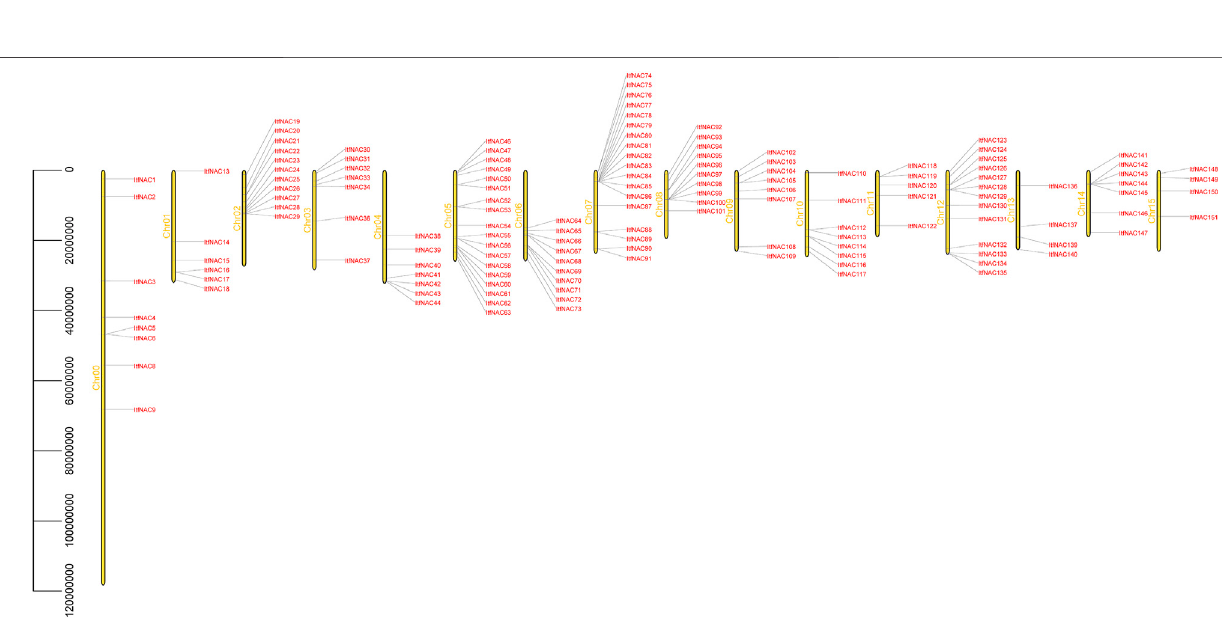
Frontiers in Genetics |